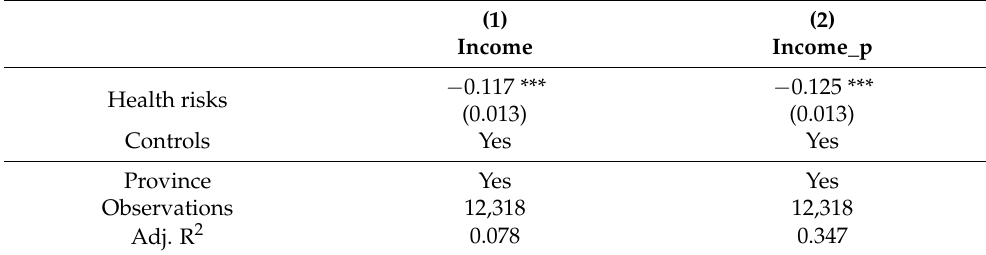
Table 7. The impact of health risk on rural household income: the OLS model.